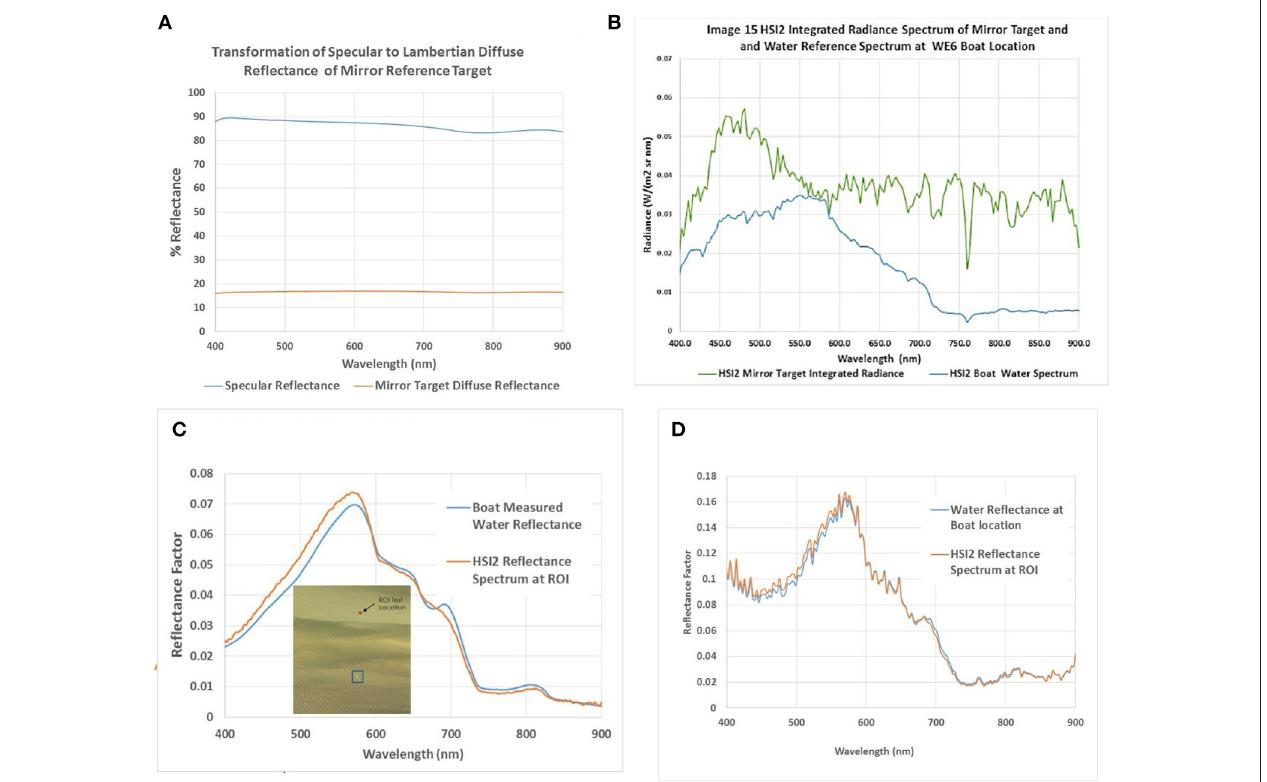
FIGURE 3 | (A) Specular reflectance factor and Lambertian equivalent reflectance factor spectra, calculated from Equation (4). (B) Resultant average NASA Glenn, second generation Hyperspectral imager (HSI2) water and mirror radiance spectra representing the low calibration reference spectrum (HSI2 Boat Water Spectrum) and the high cal reference (HSI2 Mirror Target Integrated Radiance). (C) Empirical line method 2 (ELM2) transformation reflectance spectra of water pixels extracted from the HSI2 15_MBSP swath (inset, red region of interest; ROI), compared to in situ reflectance spectra measured concurrently using the Analytical Spectral Devices (ASD) FieldSpec HandHeld 2 (HH2) around the boat at station WE6 (insert, blue box). (D) Empirical line method 0 (ELM0) transformation reflectance spectra of the same pixels shown in (C) for comparison.